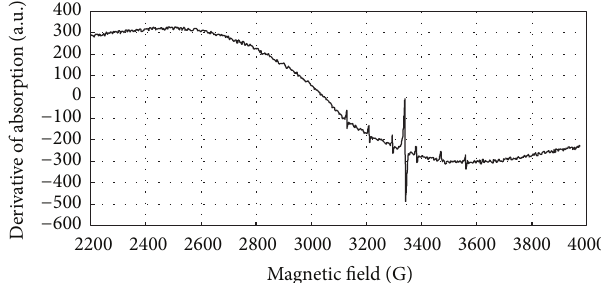
Figure 6: EPR spectrum type I (metaphosphate glasses, 50mol% CuO).